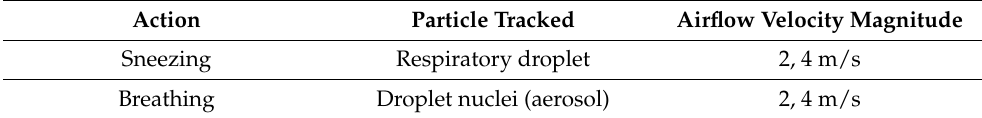
Table 2. Simulated conditions.